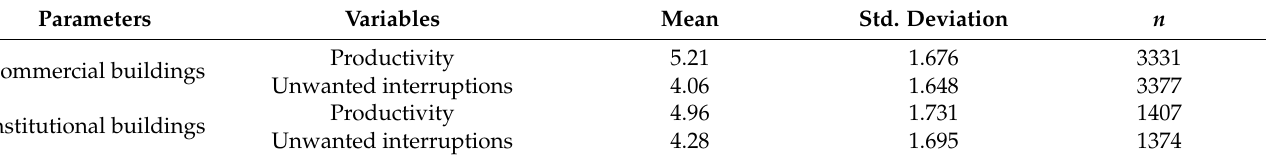
Table 4. Descriptive statistics of productivity and unwanted interruptions in commercial and institutional buildings.